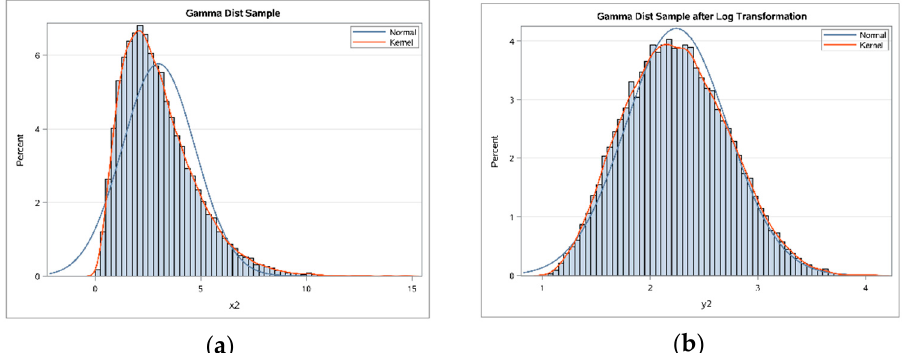
Figure 1. Simulated data from gamma distribution before and after log transformation. ( a ) The Simulated data from gamma distribution before and after log histogram of the sample before the application of log transformation with fitted normal and kernel curves; ( b ) The histogram of the sample after the application of log transformation with fitted normal and kernel curves.